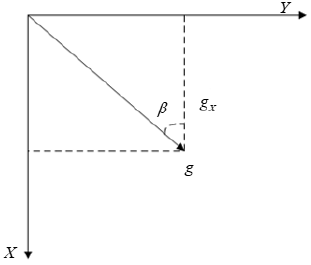
Figure 6. Solution to the angle of acceleration.